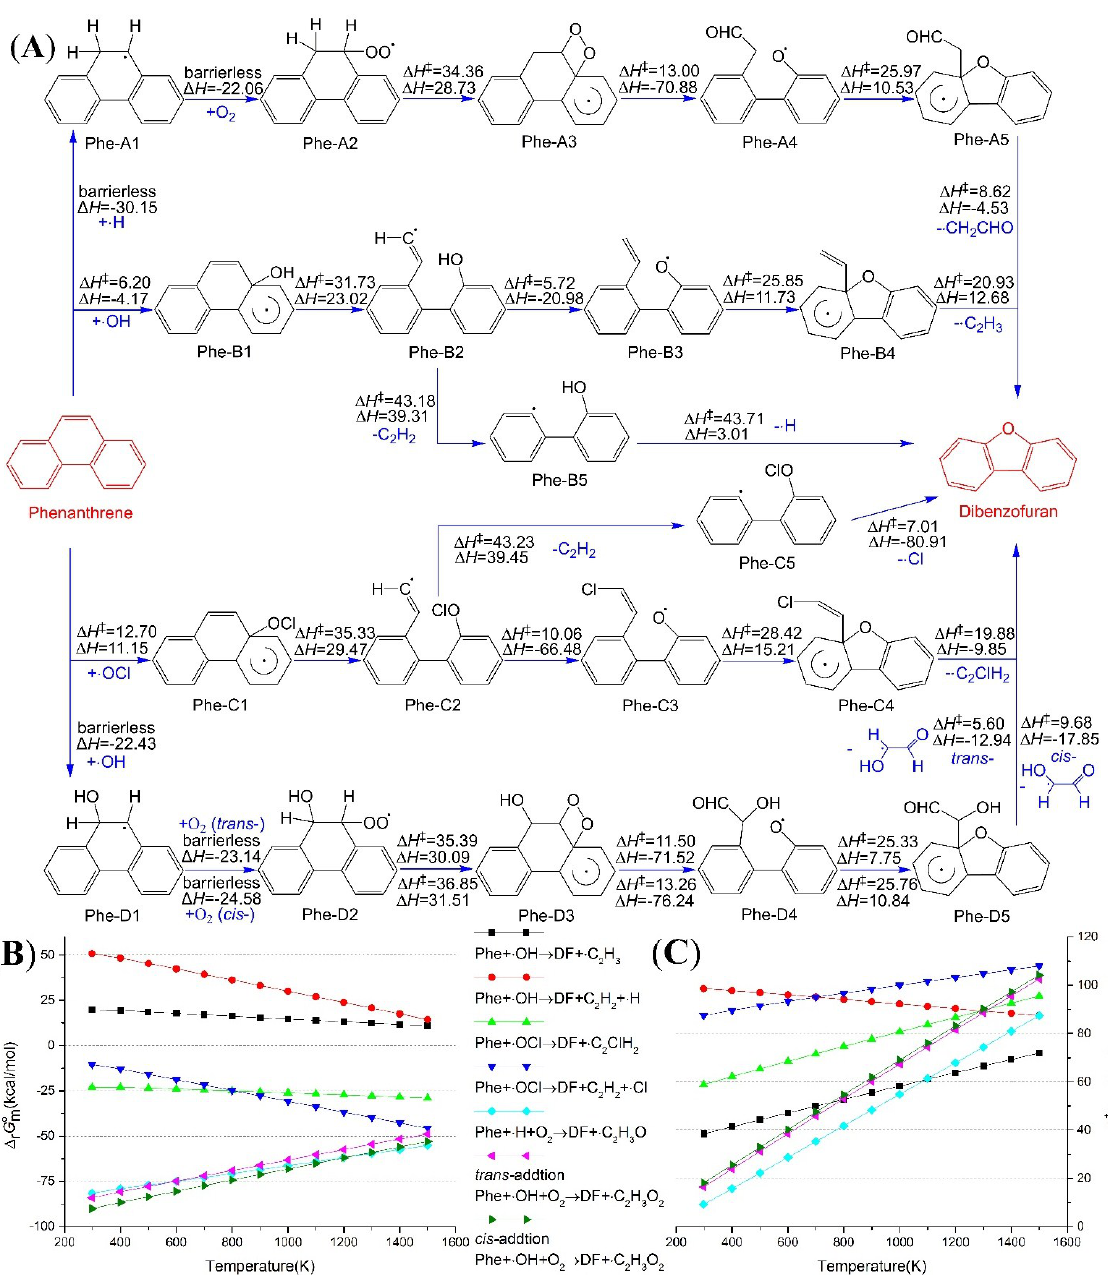
Figure 1. Dibenzofuran formation paths from phenanthrene (Phe); ( A ) Reaction scheme, enthalpies were calculated at 1000 K, and energy unit is kcal/mol; ( B ) Standard Gibbs energy changes for the overall reactions; ( C ) Activation Gibbs energies for the overall reactions (We accumulate the Gibbs energy change of each elementary reaction in turn, and the maximum value in a reaction route at given temperature is selected for the ∆𝐺 ‡